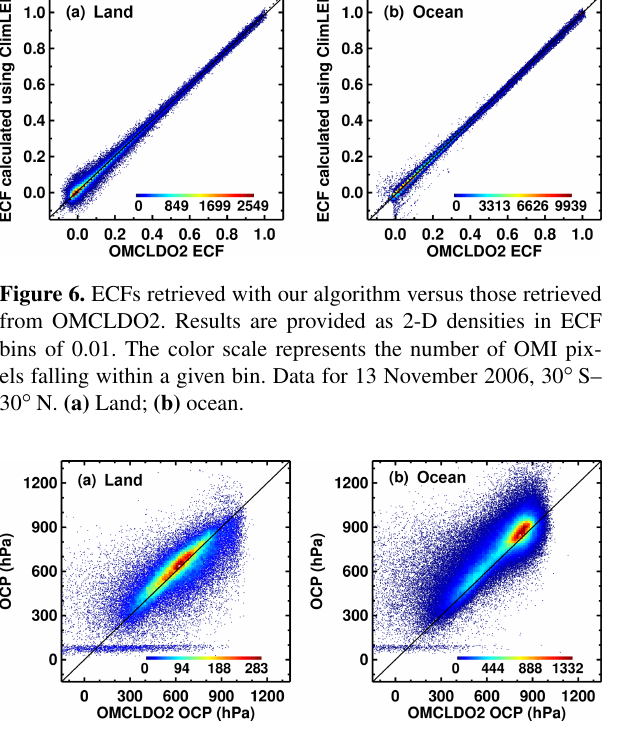
Figure 7. Similar to Fig. 6 but for